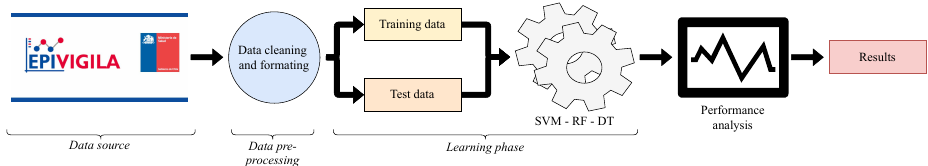
Figure 1. Proposed